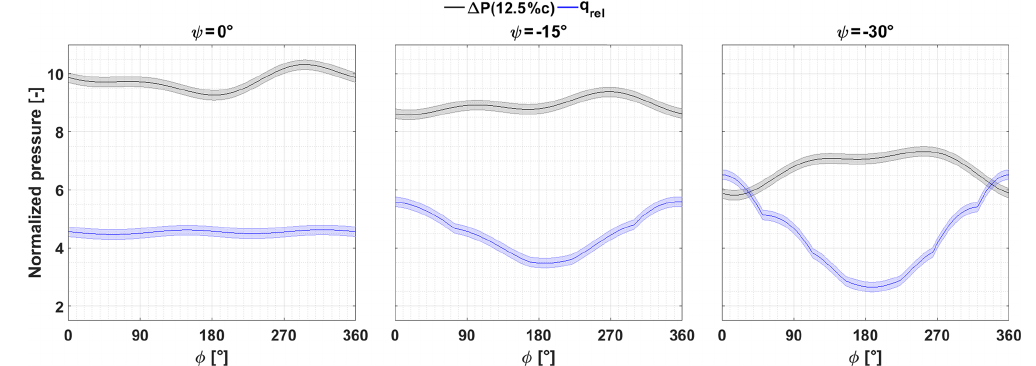
Figure 11. Results from pressure taps at r = 45% R . For three yaw angles, relative dynamic pressure ( q rel ) and pressure difference between the pressure and the suction side of the blade at 12 . 5% c variations with azimuth angle. Values are normalized by the dynamic pressure q ∞ .